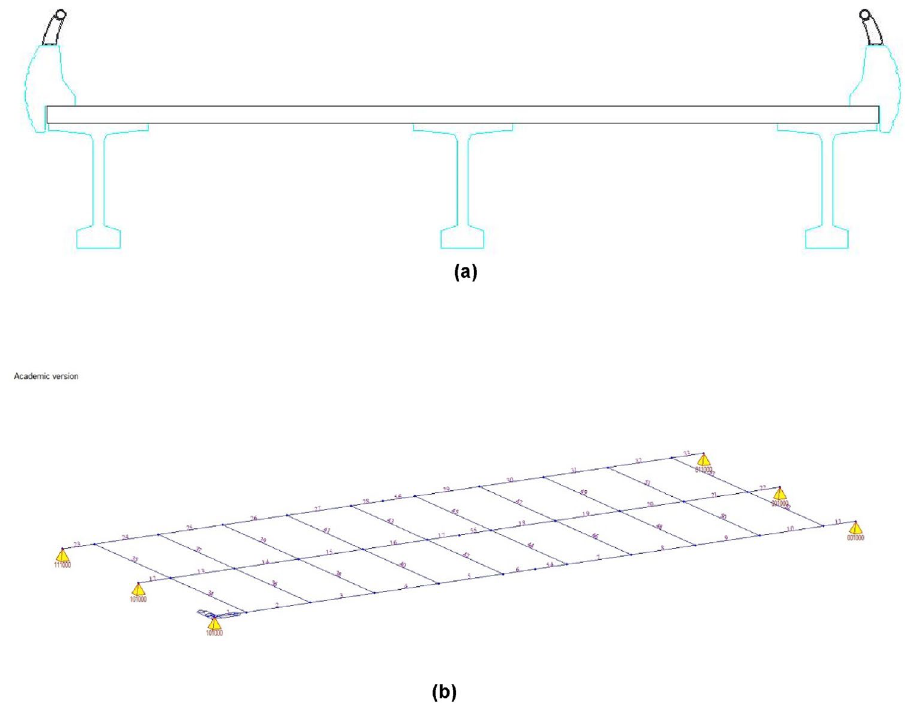
Figure 1. Grillage discretization: ( a ) girder bridge deck cross section; ( b ) structural grillage model.